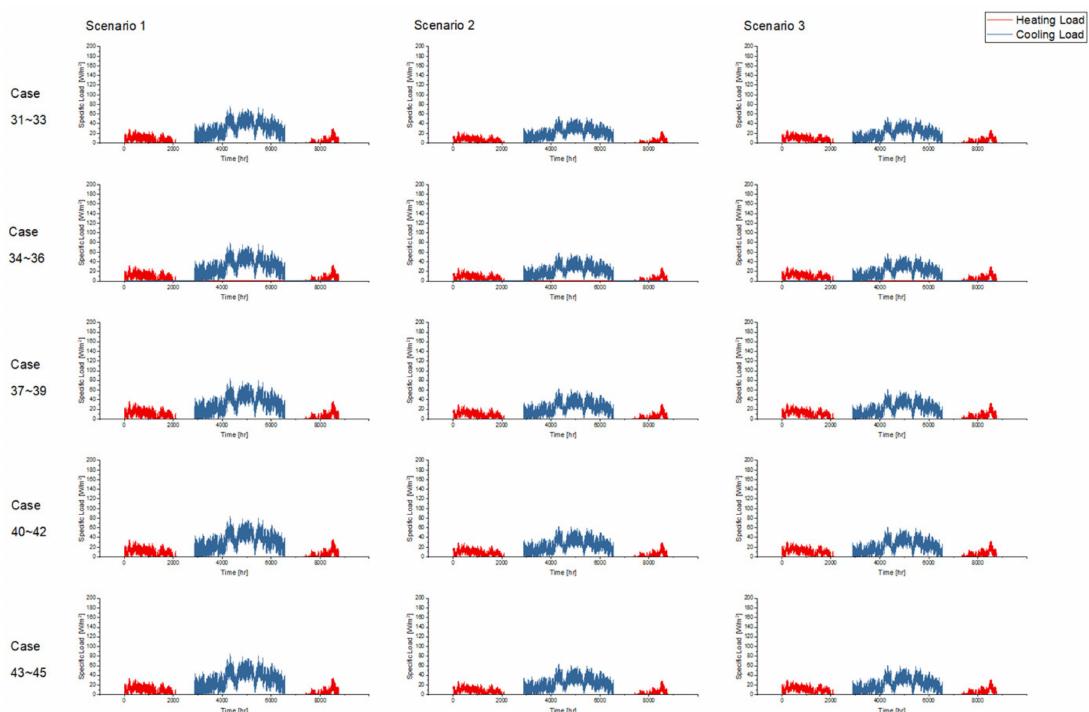
Figure 15. Original results of Cases 31~45.